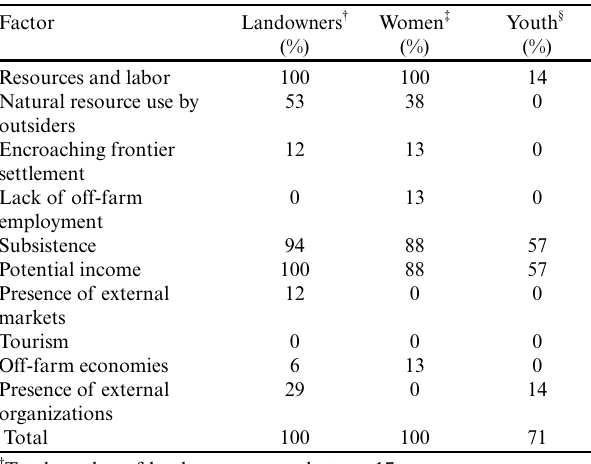
Table 1 . Economic factors that influence land-use decisions, as mentioned by